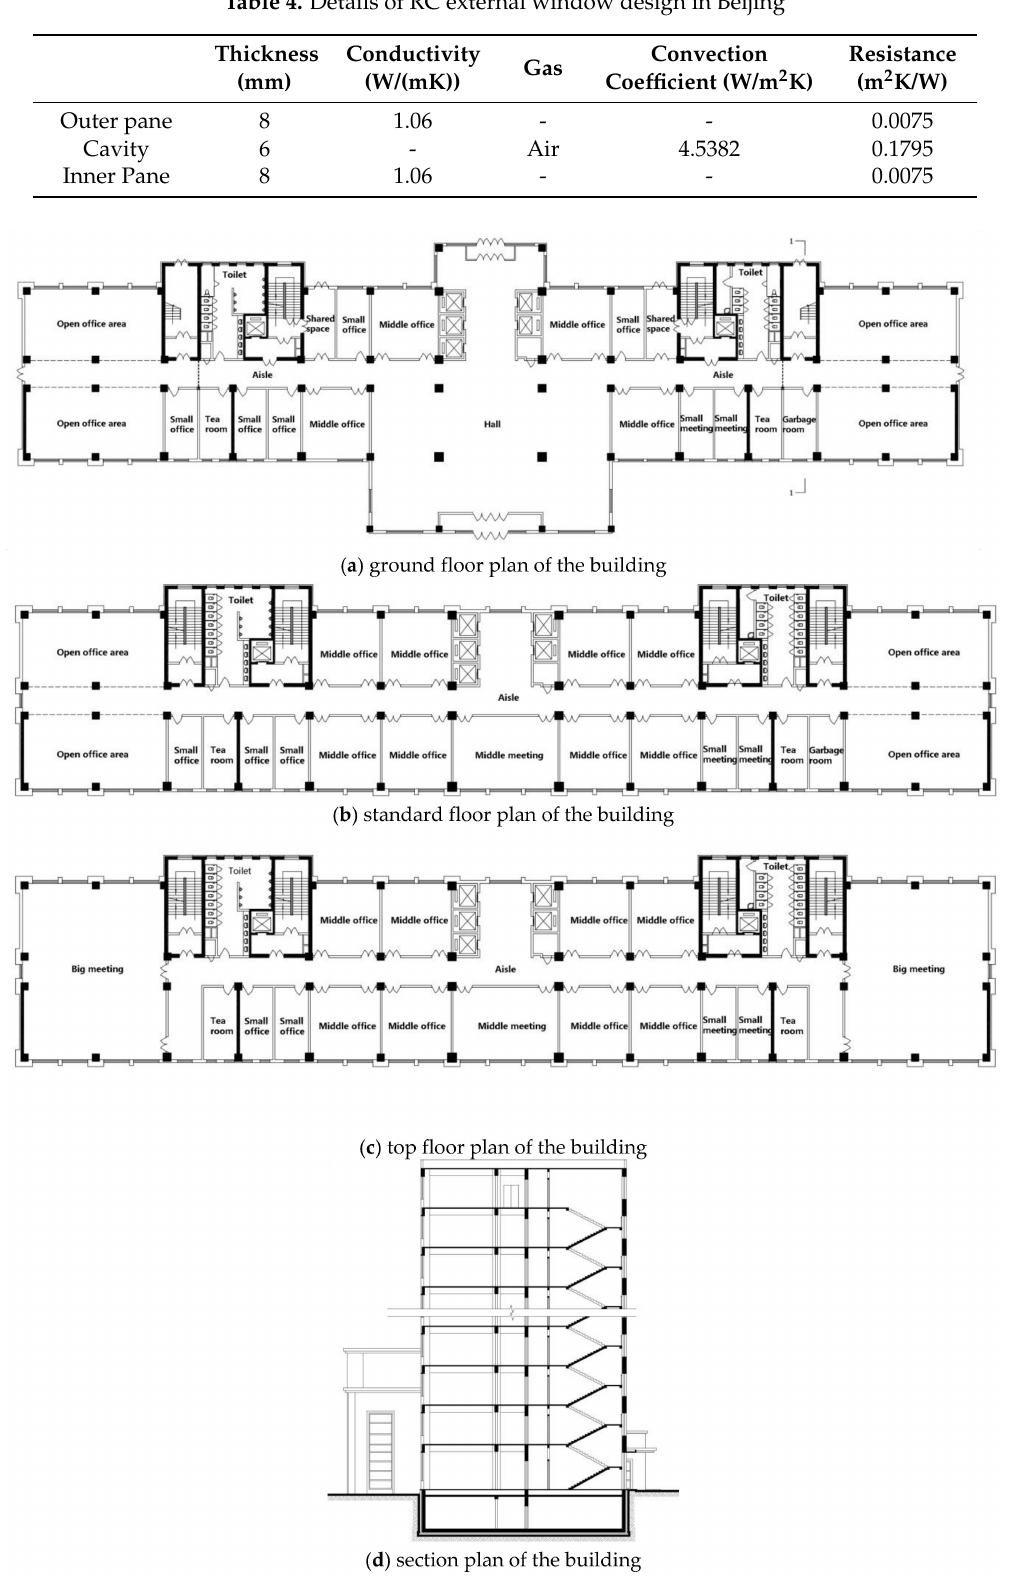
Figure 3. Floor plan and section of the case study